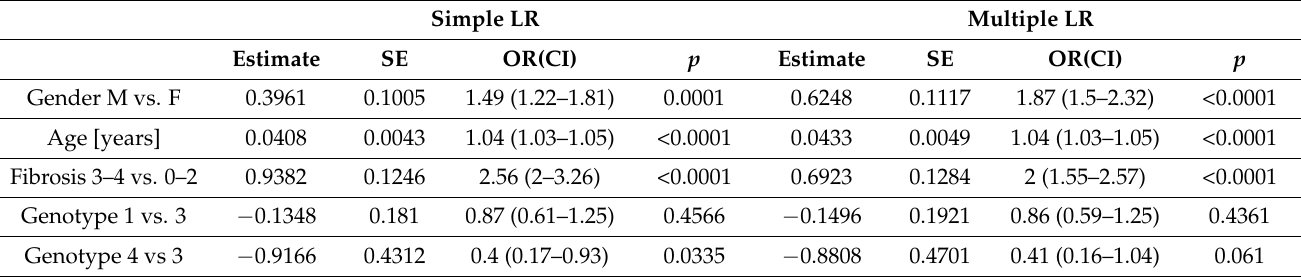
Table 4. Factors associated with the prevalence of diabetes—logistic regression. OR (CI): odds ratio with 95% confidence interval; SE: standard error of the estimate.